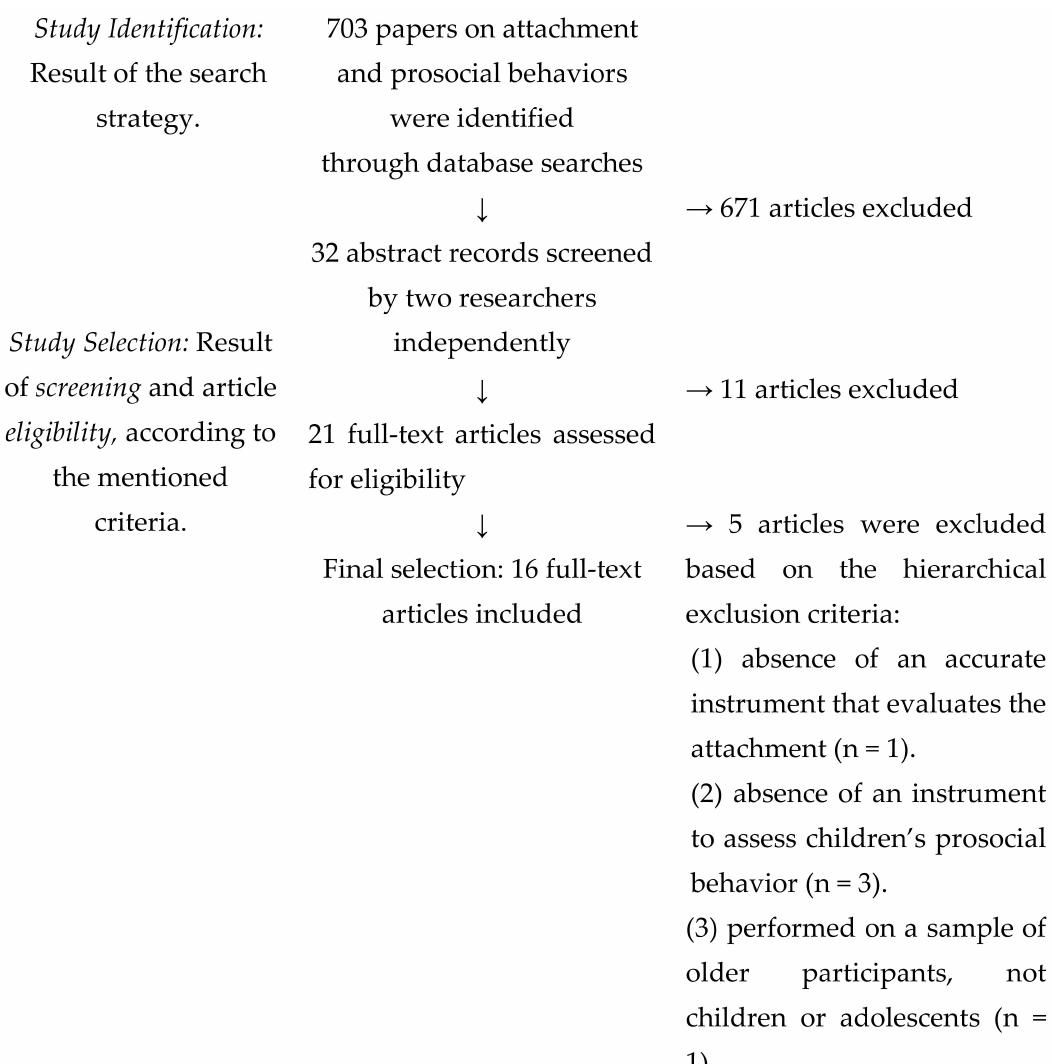
Figure 1. Flowchart of the full process of the identification and selection of the studies (according to the PRISMA, Page et al., 2020